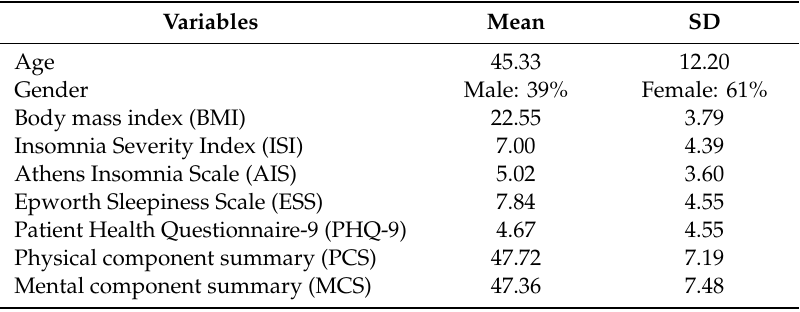
Table 1. Demographic characteristics and descriptive statistics of all measures.